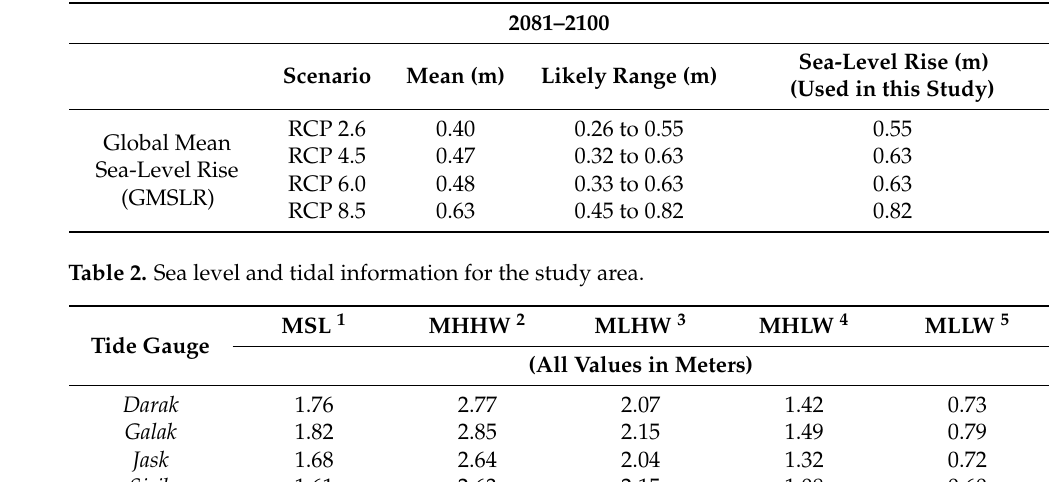
Table 1. Global mean sea-level rise by 2100 under RCP scenarios.